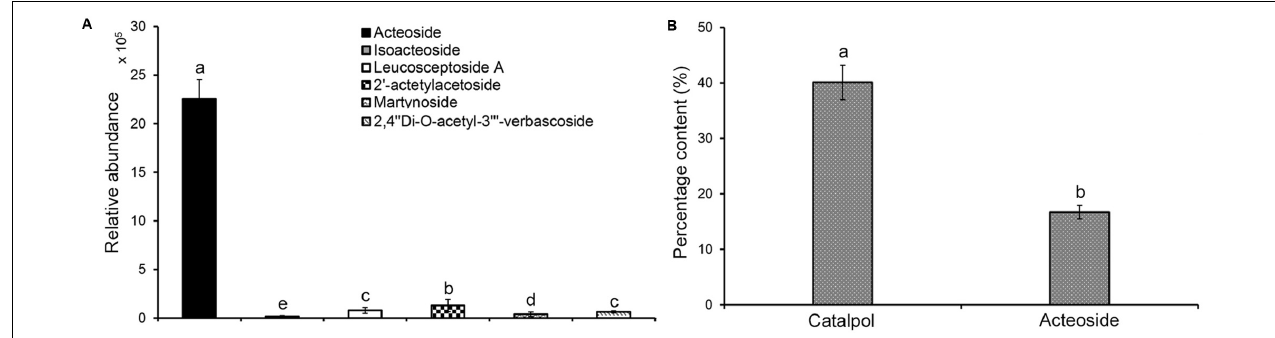
FIGURE 3 | Quantification of catalpol and six phenylethanoid glycosides in R. glutinosa root exudates. (A) Relative abundance of six phenylethanoid glycosides in R. glutinosa root exudates. (B) Percentage content of catalpol and acteoside in R. glutinosa root exudates. Different letters indicate statistical difference ( p < 0.05).